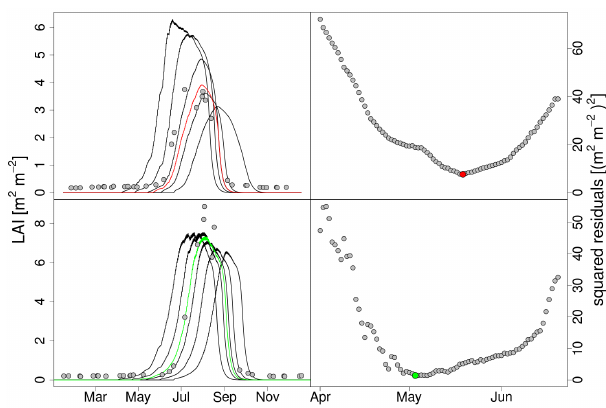
Fig. 3. Left panels: Model LAI curves are shown for maize (top) and soybean (bottom) and 5 different sowing dates (DOY 90, 110, 130, 150, 170, black lines) for one study area example field patch. MODIS LAI values are shown as grey dots. Model LAI with lowest squared residuals is shown as coloured line. Right panels: Squared residuals between model LAI and MODIS LAI for each of the 80 sowing dates and maize (top) and soybean (bottom). The coloured dot depicts the lowest squared residuals value.